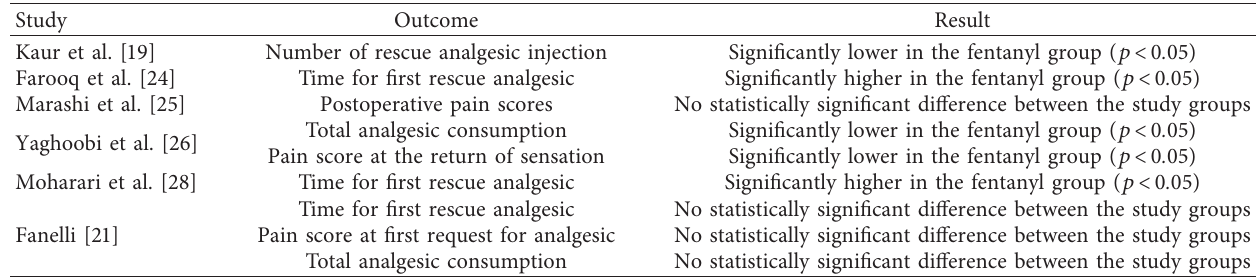
Figure 11: Meta-analysis of complications between fentanyl and control groups. Table 4: Postoperative analgesic